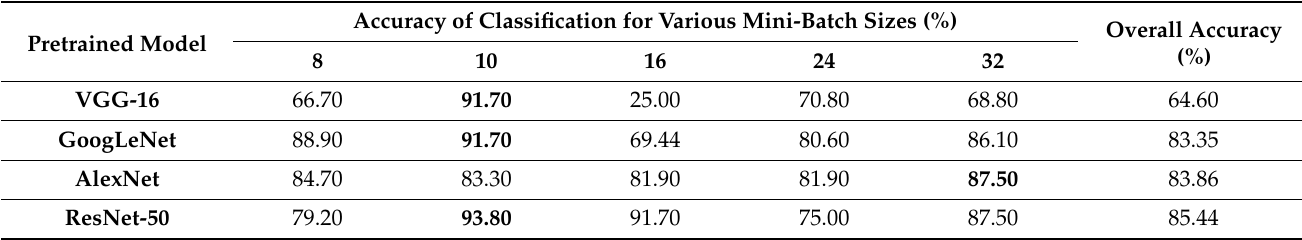
Table 6. Performance of pretrained networks for different minibatch